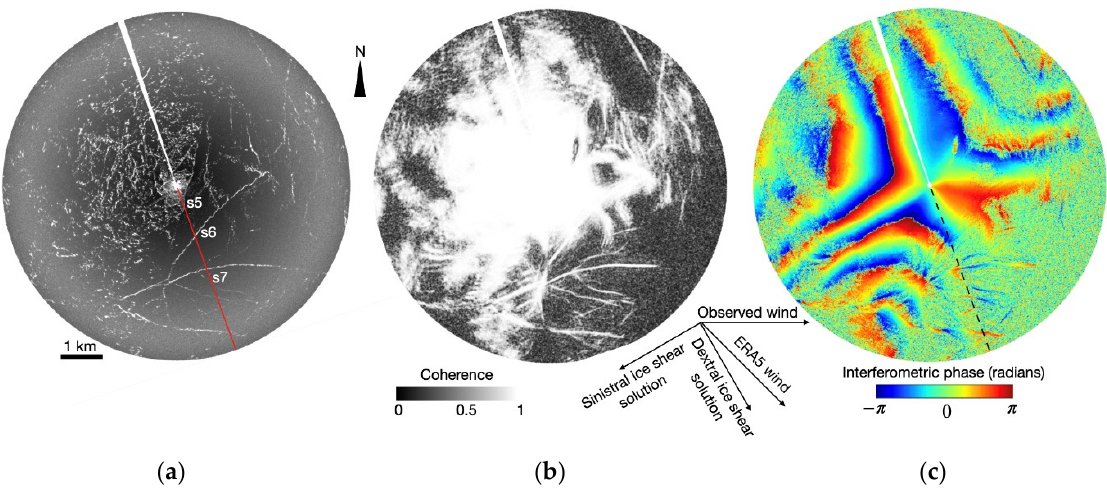
Figure 6. ( a ) Backscatter from the GPRI during the ICEX 2020 campaign. ( b ) Coherence values between acquisitions acquired on 10 Mar 2020 at 05:00 UTC and 19:30 UTC. ( c ) Interferogram resulting from the acquisitions in ( b ). Arrows indicate approximate wind direction from ERA5 reanalysis and the direction of shear as estimated based on the fringe pattern. s5–s7 in ( a ) represent strong scatterers with high coherence commented on in the text. dB units for backscatter cannot be derived due to the lack of in-situ corner reflectors. Direction of the stare acquisitions is indicated with a red line in ( a ) and a black dashed line in ( c ).